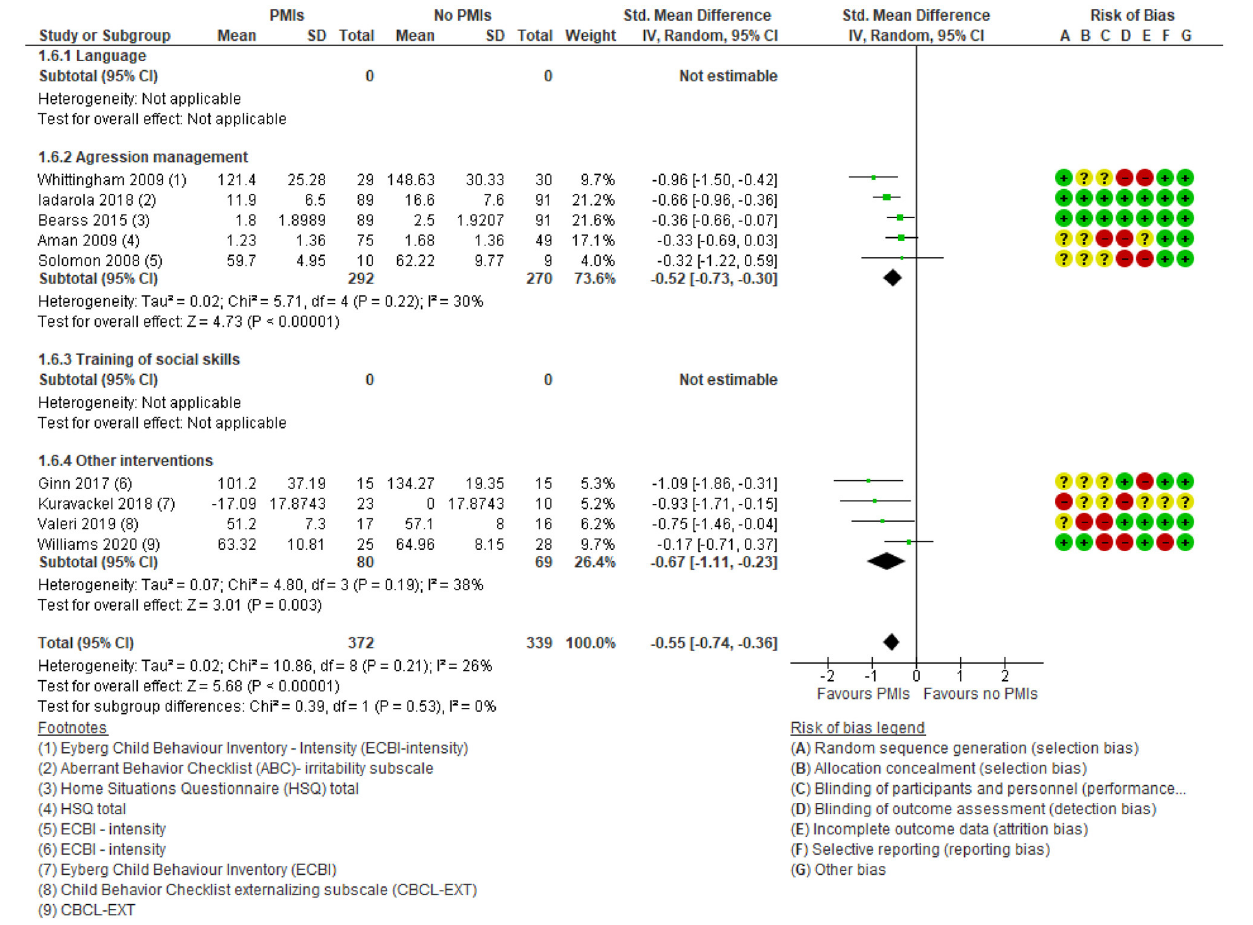
FIGURE 9 | Forest plot of comparison: PMI vs. no PMI, outcome: disruptive behavior,